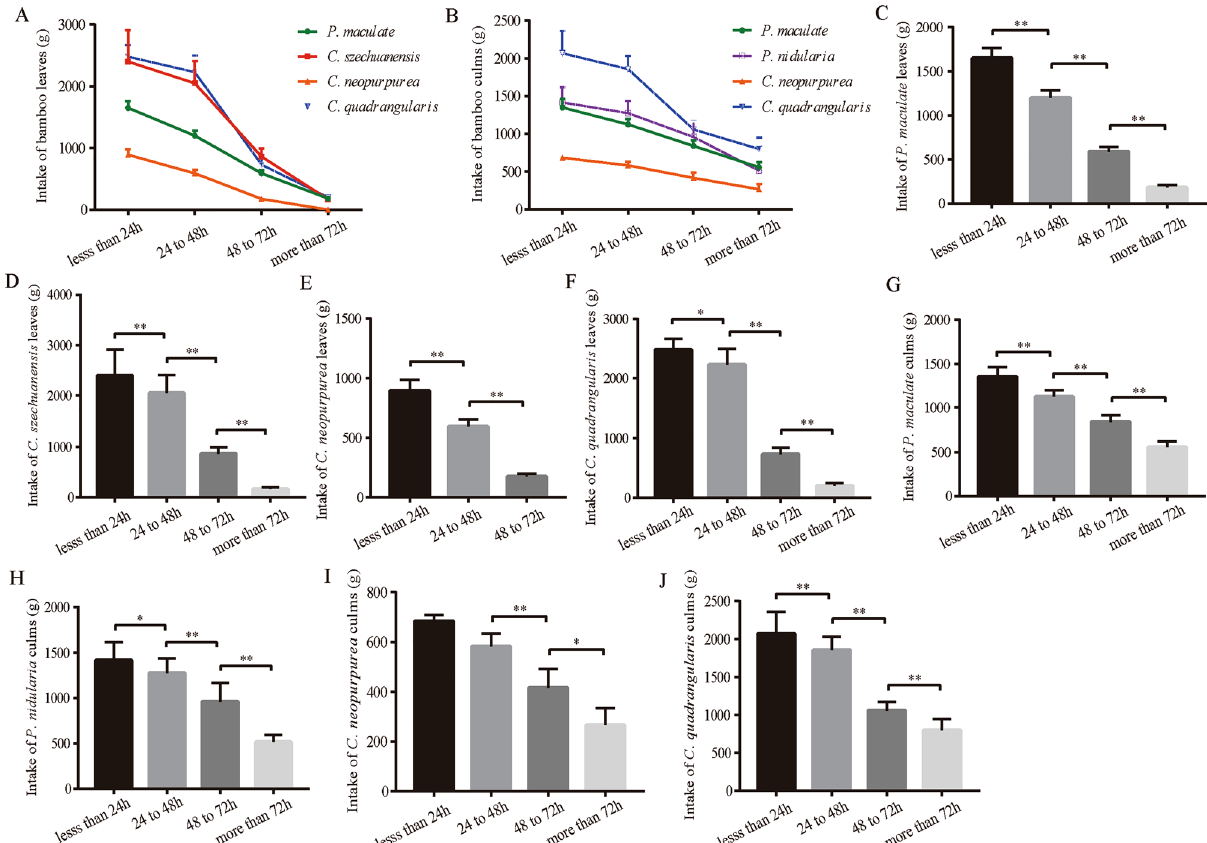
Figure 4. Feed intake of bamboo for captive giant pandas at different feeding